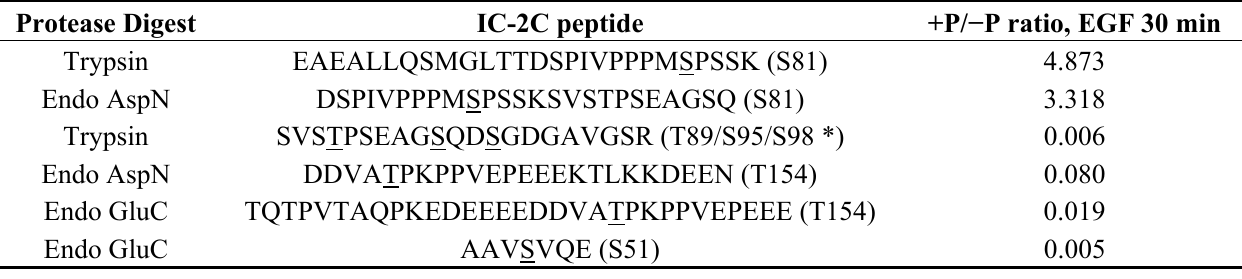
Table 1. Identification of six phosphorylation sites in IC-2 from EGF-stimulated cells.